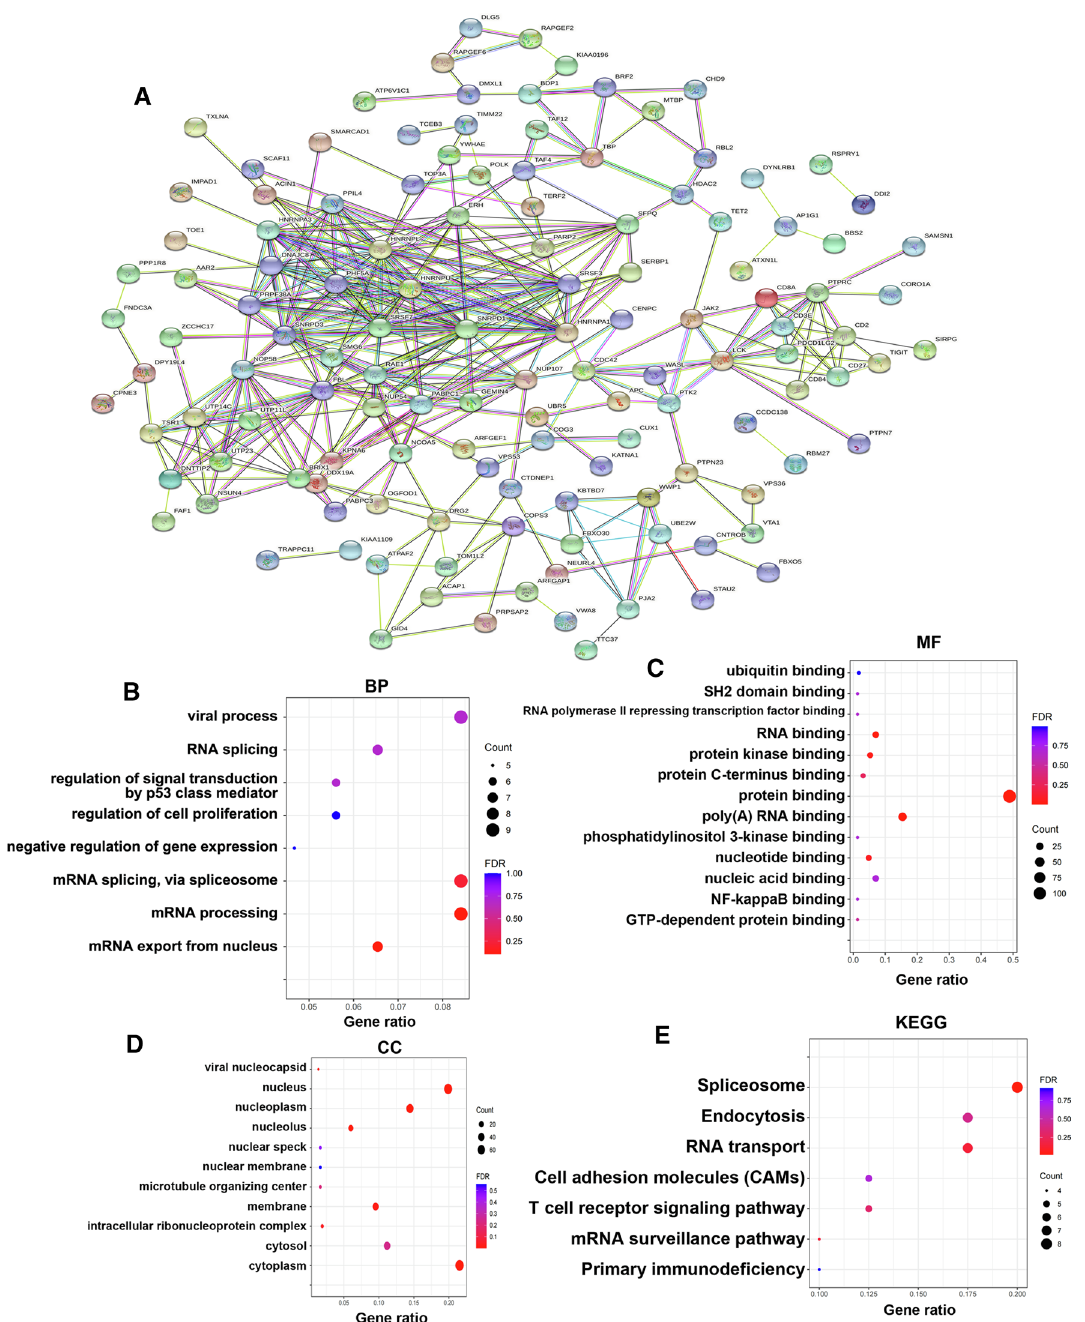
Fig. 7 GO and KEGG enrichment analysis of m6A regulators and their 170 co-expression genes in HCC patients. (STRING and DAVID). A PPI network. The nodes meant proteins; the edges meant the interaction of proteins B BP. C MF. D CC. E